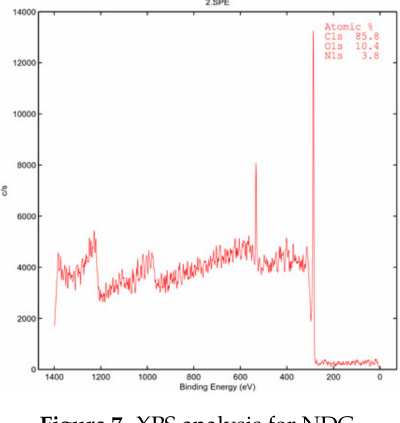
Figure 7. XPS analysis for NDG. Table 1. Chemical composition of the nitrogen-doped graphene